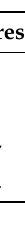
Figure 7. Comparison between Jetson TK1 and Odroid XU wearable boards on the task of SIFT extraction. Table 2. Average number of SIFT features extracted at different frame